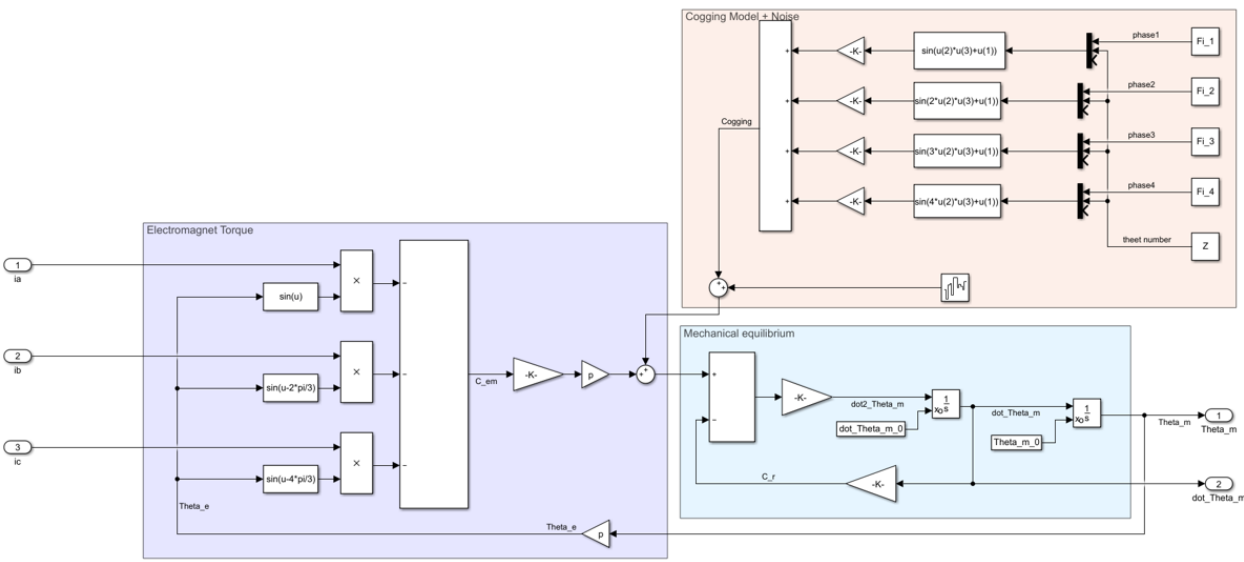
Figure 10. Example realization in MATLAB/Simulink environment of the subsystem related to mechanical